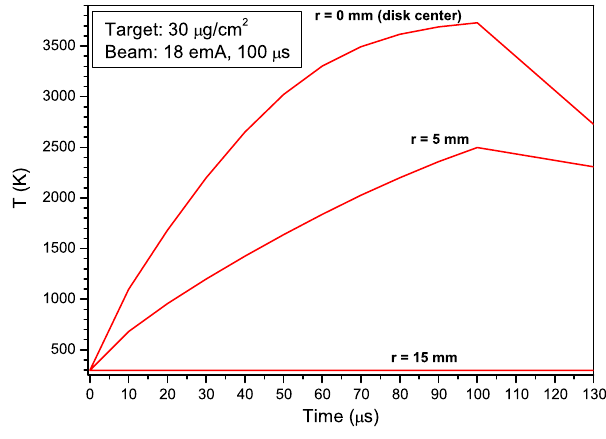
FIG. 12. Same as in Fig. 11, but for foil thickness ¼ 30 μ g = cm 2 .